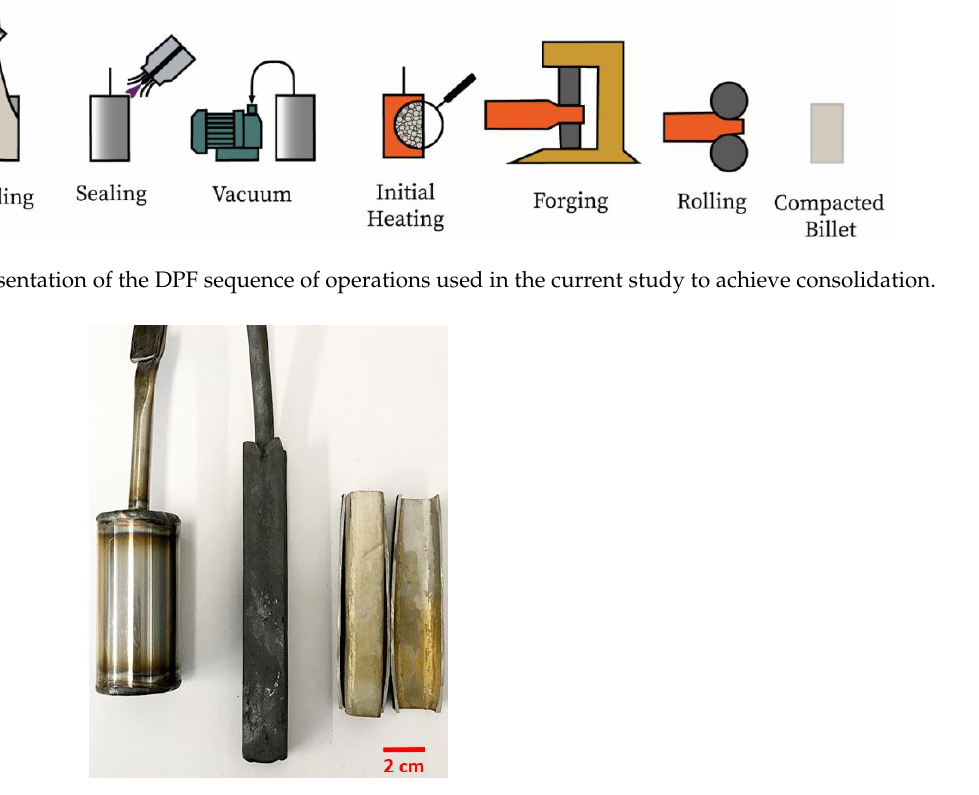
Figure 2. Photograph presenting a new sealed canister ( left ), a forged billet ( center ) and a cut-out sample ( right ).